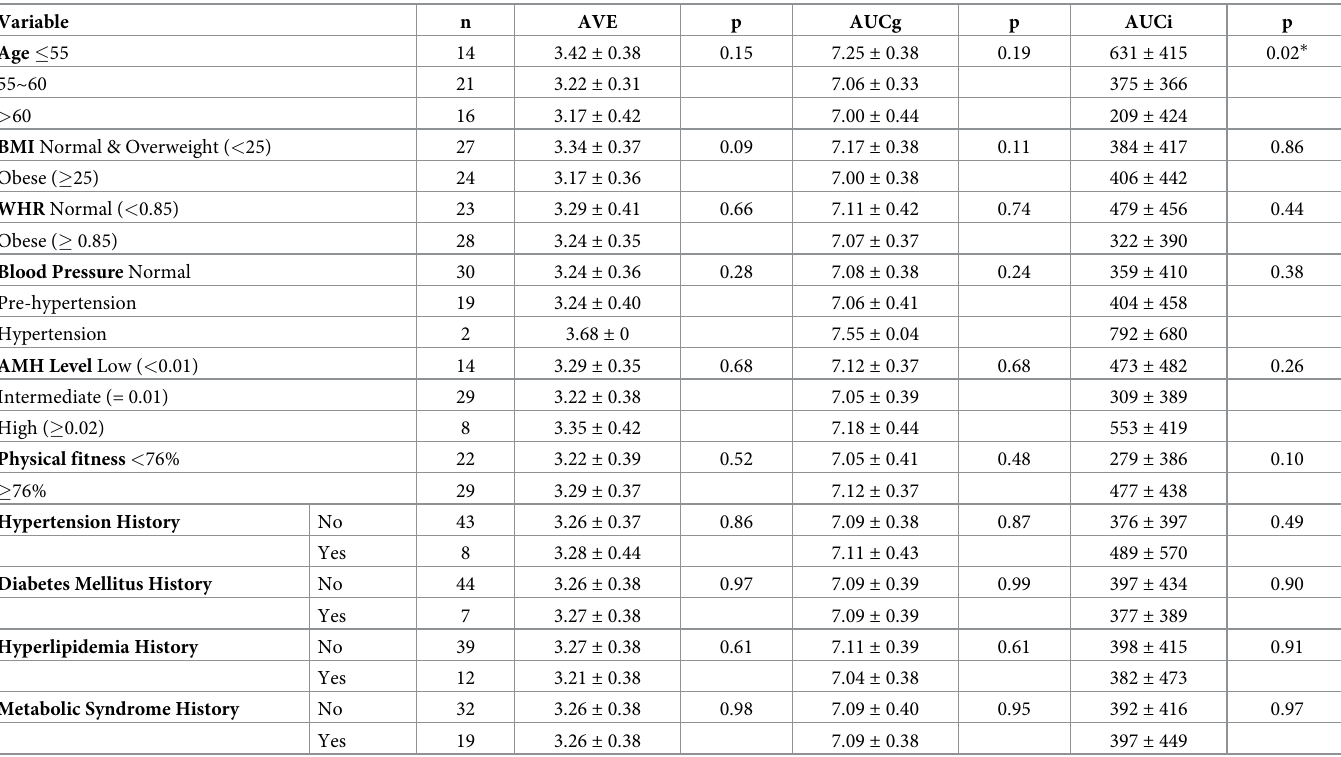
Table 1. Differences in CAR based on individual characteristics before the marine healing program.